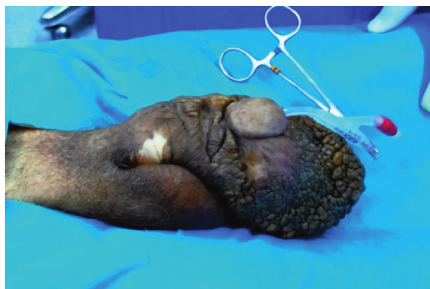
Figure 2: Giant fibroepithelial mass measuring at 13cm on the ventral aspect of the shaft and glans penis.